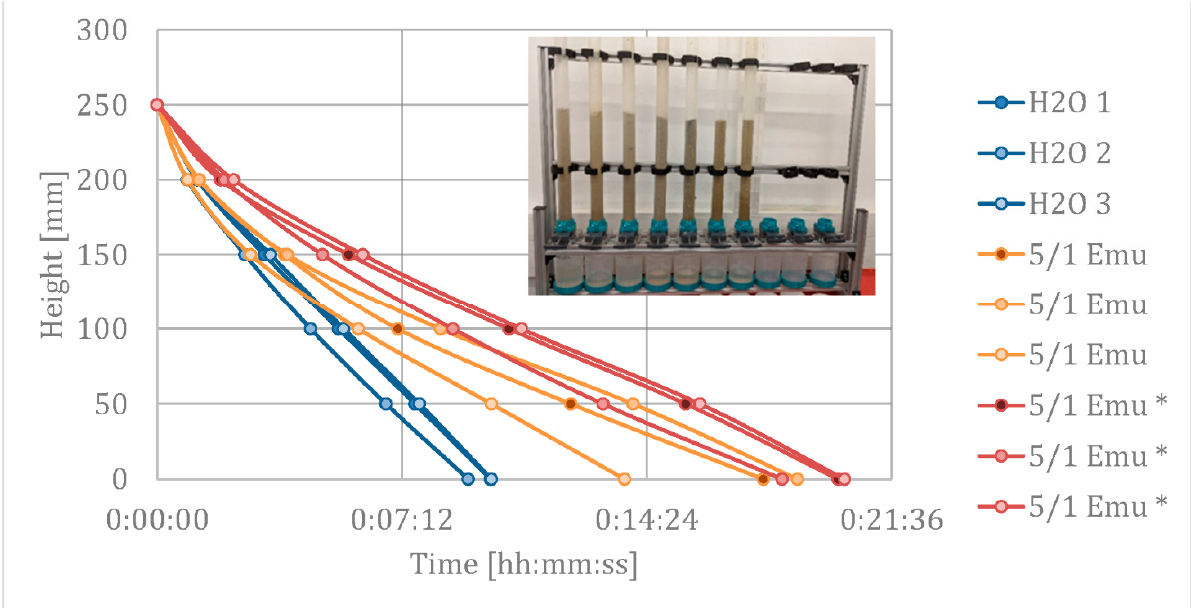
Figure 5. Lab trials to determine the speed with which water and emulsions travel through the soil. Sand from the brownfield N77 was used as a substrate. It was compressed in the glass columns to obtain comparable conditions. The three curves are the first, second and third passages, with dry and wetted sand. The insert shows the experimental setup. Emu = emulsion; The * stands for trials where the sand was wet.